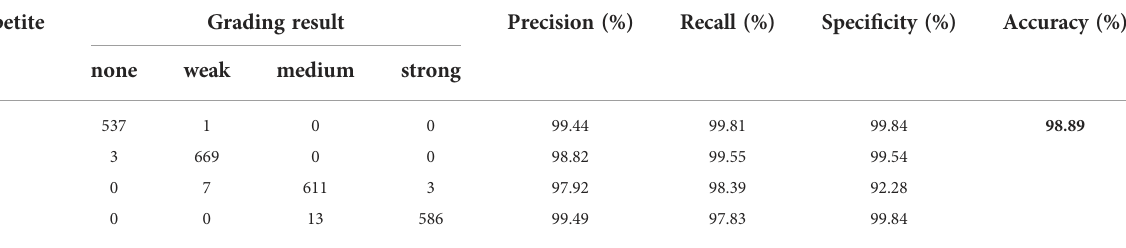
TABLE 2 Grading results for each fi sh appetite